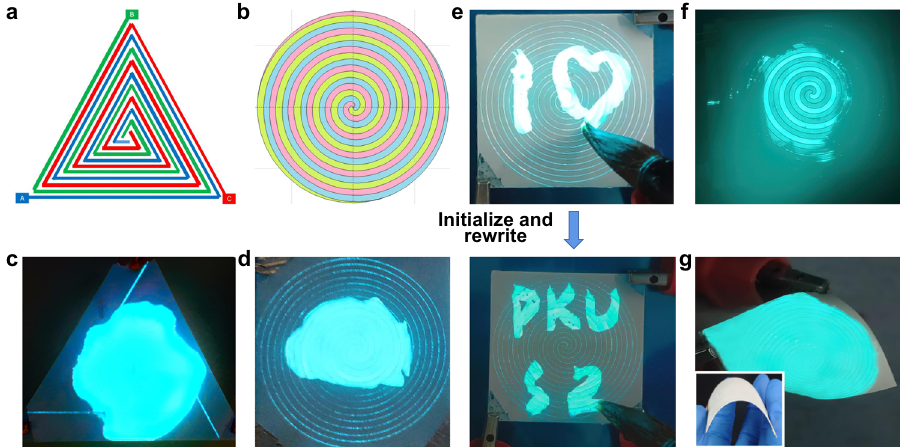
Fig. 5 Multifunctional TPEL panels for interactive rewritable displays, optical-output sensors, and general lighting. Schematic diagrams of triangle-type ( a ) and lollipop-type electrodes ( b ) for TPEL panels. Photographs of working triangle-type ( c , 4 cm side) and lollipop-type ( d , 5 cm diameter) TPEL panels with DI water as a polar bridge on the top of the devices. e Photographs of rewritable interactive display with written characters with DI water by a writing brush, erased by absorbent paper and re-written again. f Three-phase imbalance detection by remote optical alarm for simulative long-distance electric transmission lines using a TPEL panel. The three-phase voltages are 100, 110, and 120 V, respectively, at 60 Hz. g Flexibility of TPEL panels when using PET as a Electrons from the highest occupied molecule orbital of HTM injection from Al electrode occurs, which under an electric fi eld are tunneled into LUMO of HATCN to form the bound electron- move through the organic functional layers toward the dielectric hole pairs at the interface of donor – acceptor bilayer structure, layer to neutralize the negative charges in HATCN layer which dissociate in the electric fi eld, and the holes thus generated and near the dielectric surface, and re fi ll the depleted FIHGL in HTM move toward EML layer under the electric fi eld where (Supplementary Fig. 15, right). As the two other E( + / − )//EML// they form excitons with electrons injected from E1 electrode and EB( − / + ) capacitors (with electrodes E2 and E3) work in the recombine with light emission. When the voltage is reversed in same manner of cycling but with a phase shift of 120°, this results the next half-cycle to E1( + )//EML//EB( − ), the less ef fi cient hole in the current and the luminance of a TP-OLED to be more